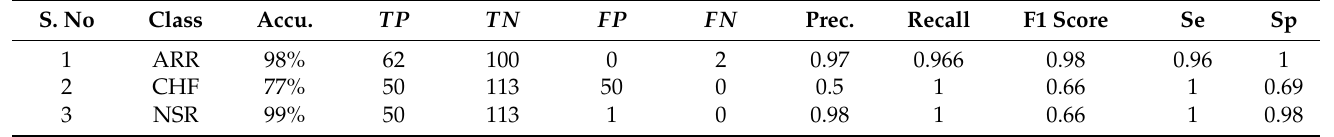
Table 5. The table represents overall accuracy, TP , TN , FP , FN , F1, Sensitivity (Se), and specificity (Sp) scores for the 2DCNN-LSTM model without k-fold